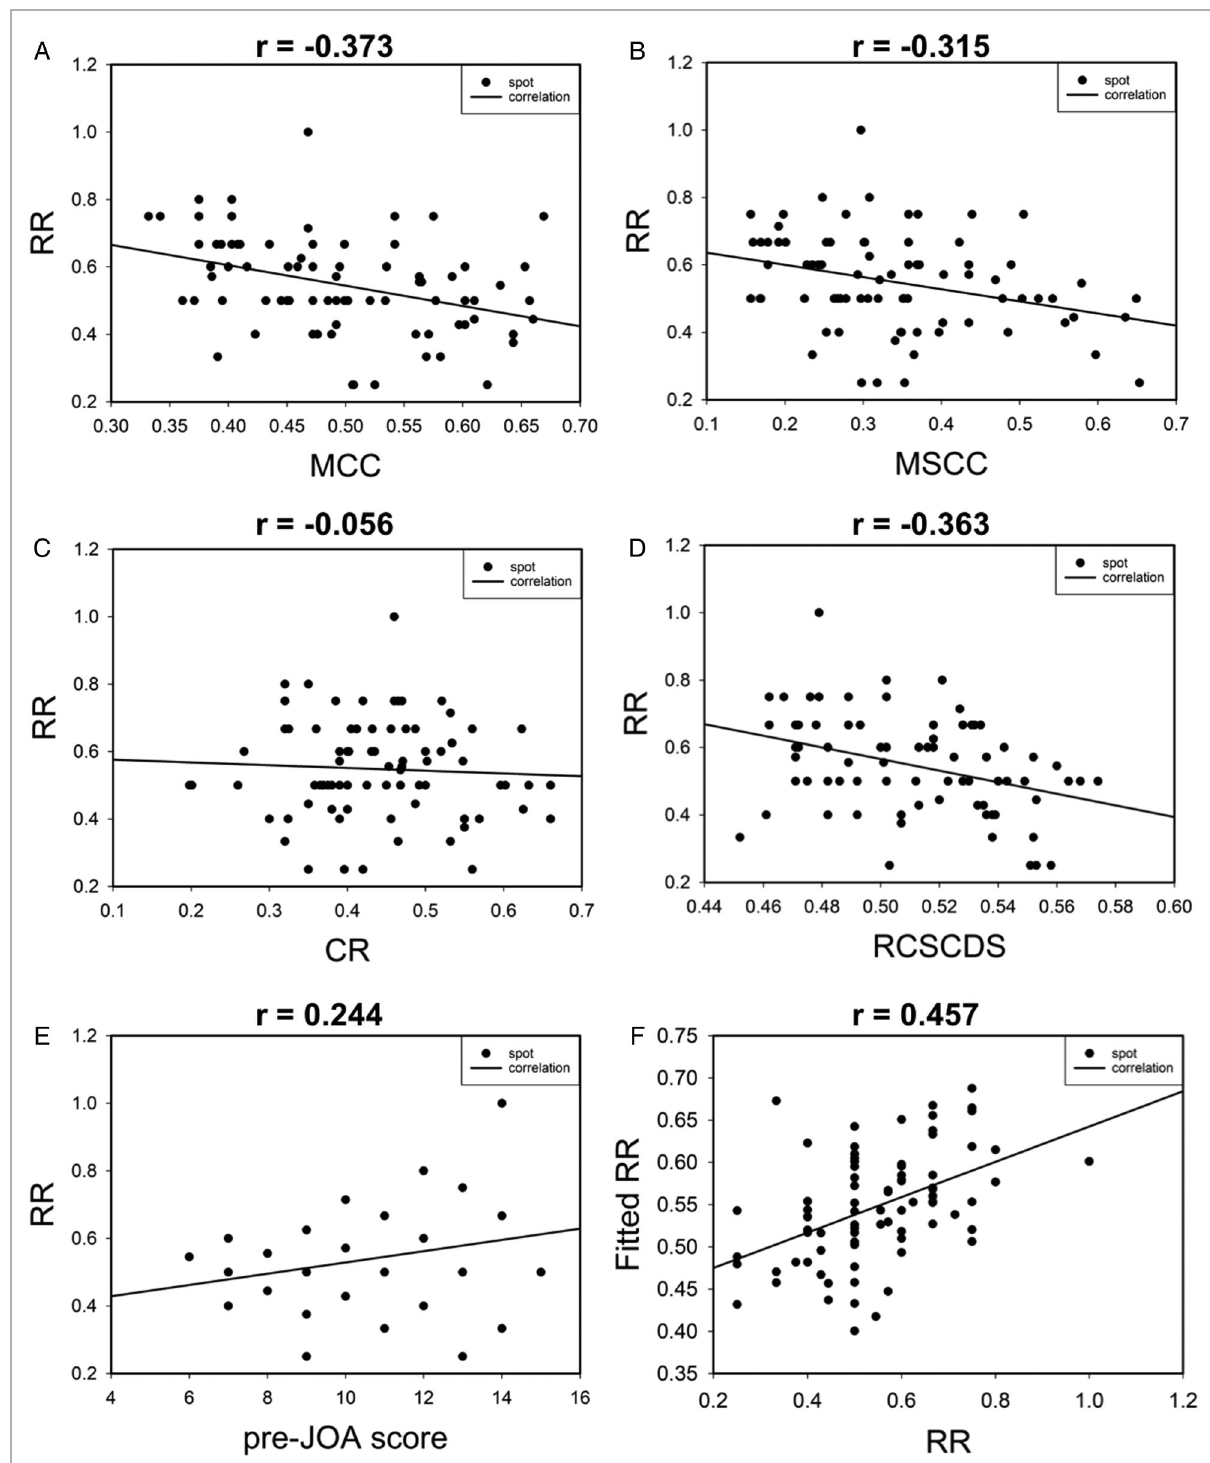
FIGURE 5 The scatter plot of correlation between postoperative recovery rate and preoperative spinal cord compression parameters ( A – D ). Correlation between postoperative recovery rate and preoperative JOA score ( E ). Correlation between postoperative recovery rate and fi tted postoperative recovery rate ( F